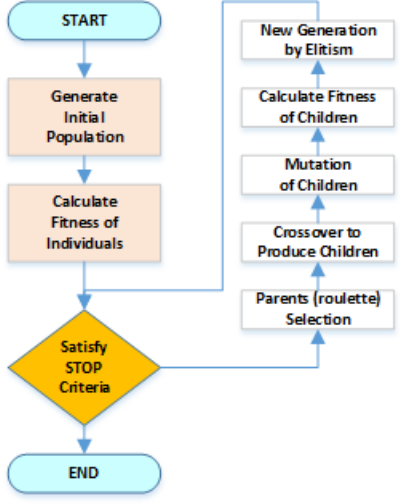
Figure 6. Co.Tr.I.S GAs general flowchart